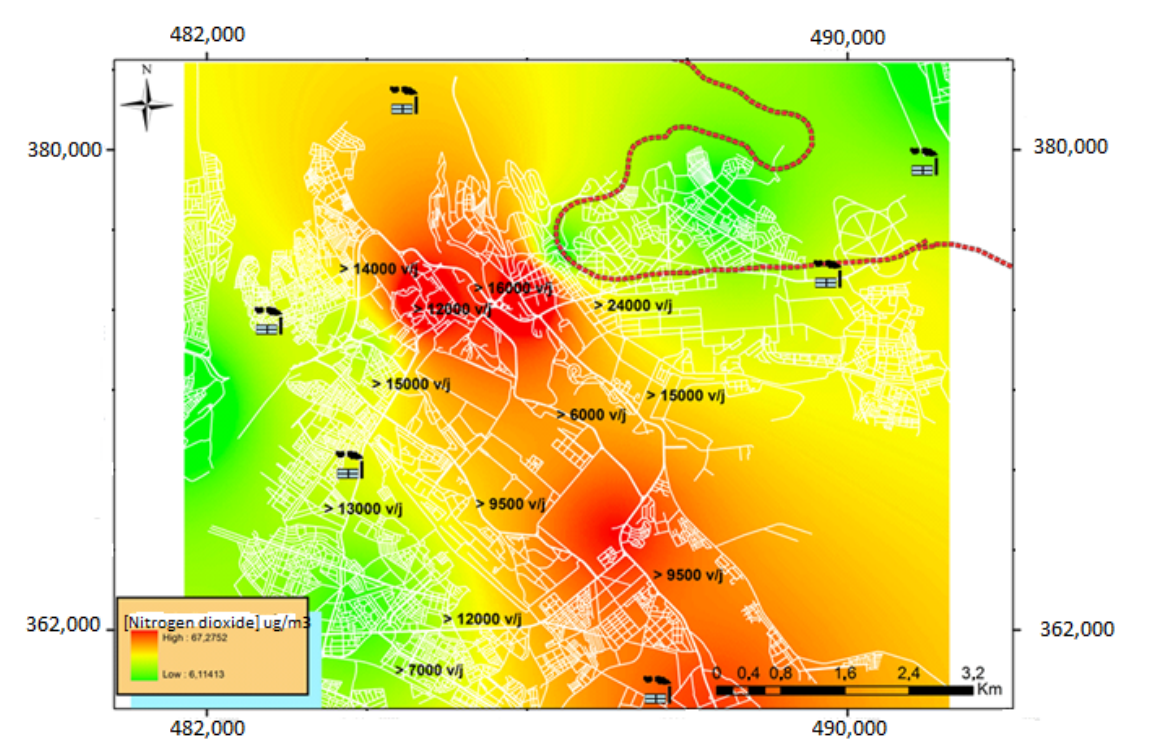
Figure 5. Increasing distribution of sites by NO 2 concentration.